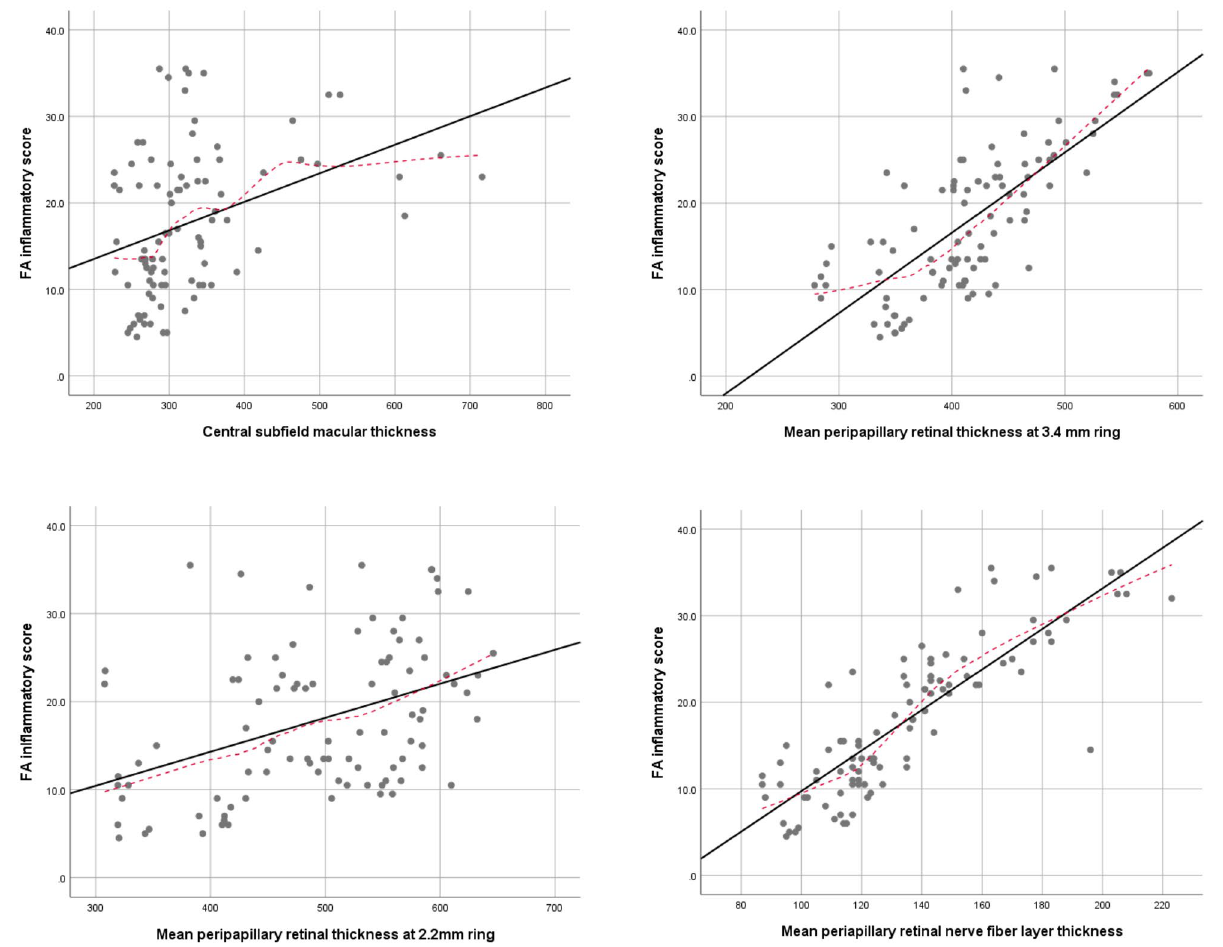
Figure 2. Scatter plot of OCT parameters and FA score: correlation of four OCT parameters with FA inflammatory score in Behcet’s retinal